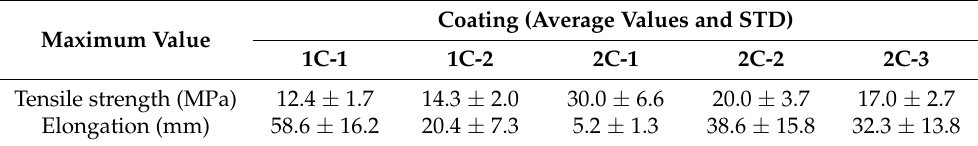
Table 3. Tensile strength and elongation of coating films.